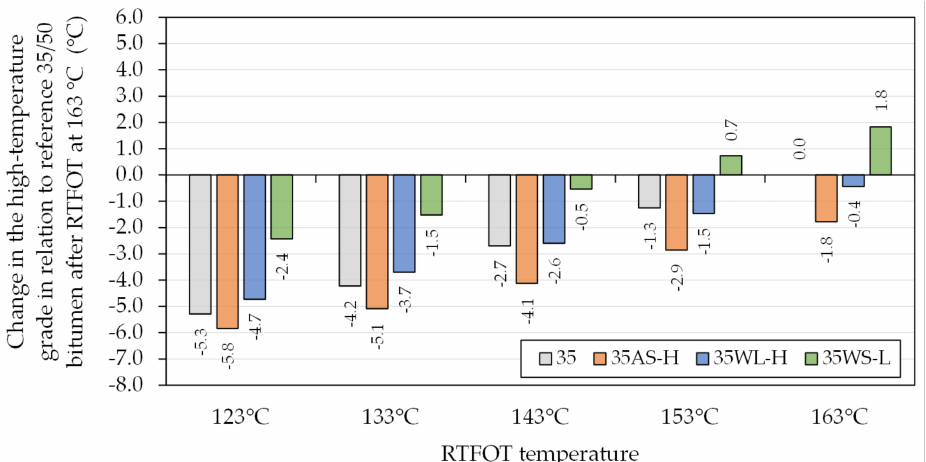
Figure 7. Change in the high-temperature grade of the investigated asphalt binders based on the 35/50-penetration bitumen due to RTFOT ageing in relation to the reference 35/50 bitumen after RTFOT at 163 ◦ C.